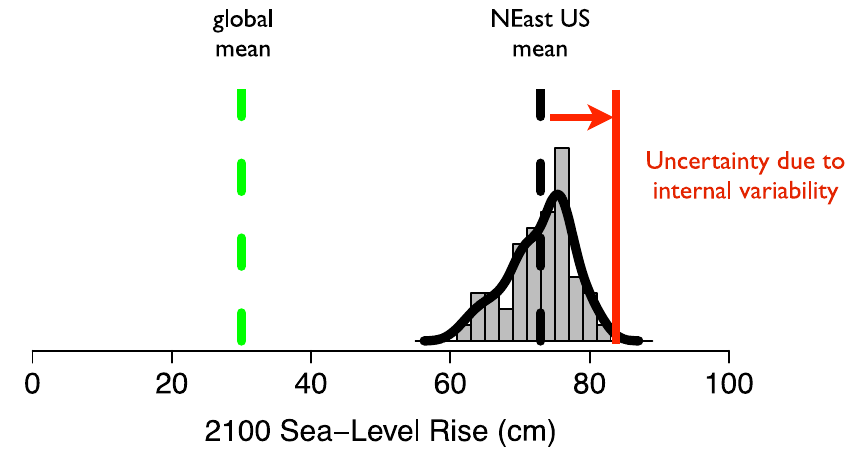
Figure 8. CESM ensemble spread of the total steric sea-level rise from 1850–2100 over the northeastern United States. The global mean total rise by this year is plotted as a dashed green line, northeastern ensemble mean as a black dashed line, and the upper bound of sea-level rise due to internal variability by the solid red line.